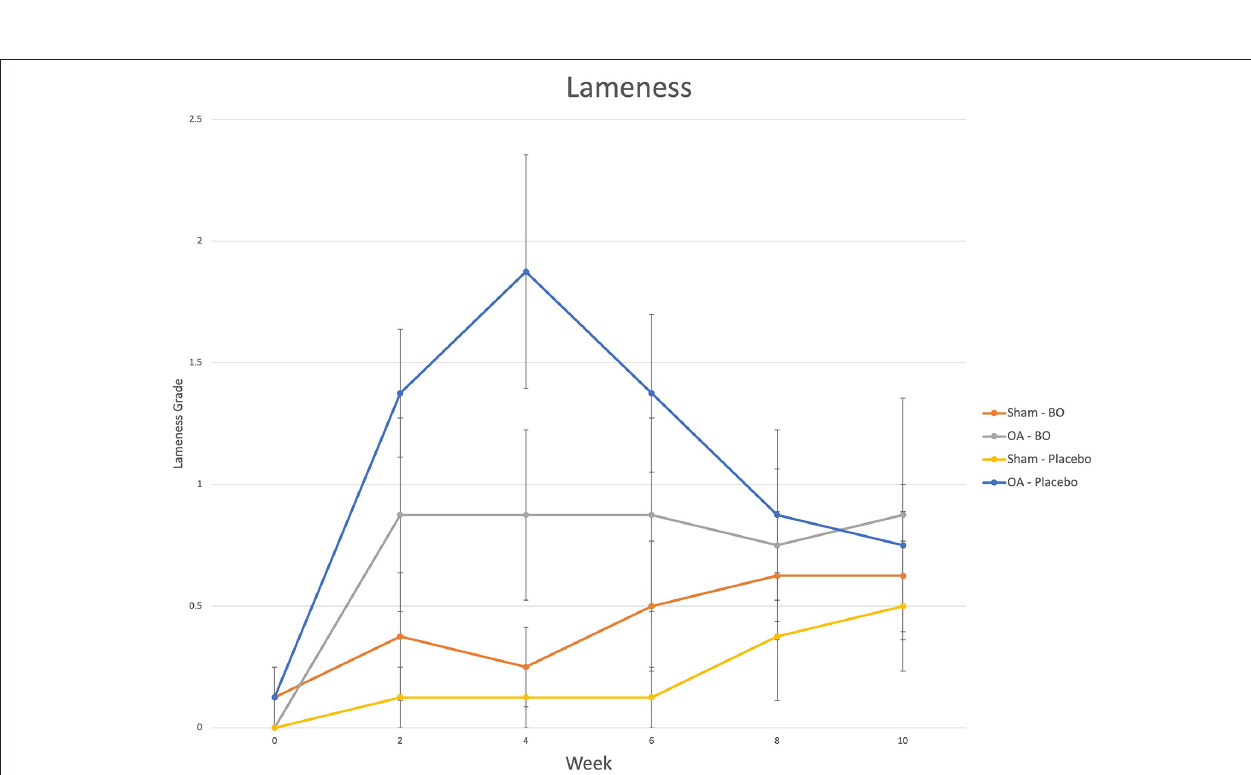
FIGURE 2 | Subjective lameness grades (0–5) were assigned to each limb on weeks 0, 2, 4, 6, 8 and 10. The means are represented for the OA limb of horses receiving the treatment (OA-BO), sham operated limb of horses receiving the treatment (Sham-BO), OA limb of horses receiving the control (OA-Placebo) and sham operated limb of horses receiving the control (Sham-Placebo). This data represents mean ( + /- SEM) from raw data and not the data upon which the statistics were run thereby a p -value does not correlate with the data presented here.